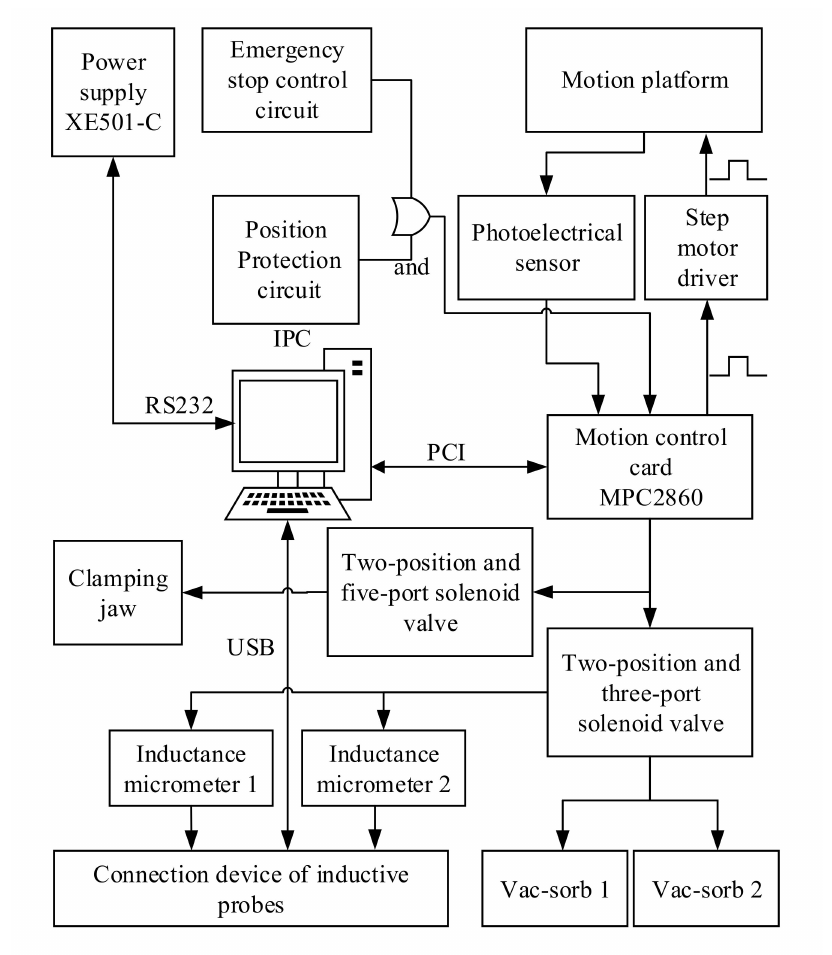
Figure 8. Schematic diagram of the circuit control